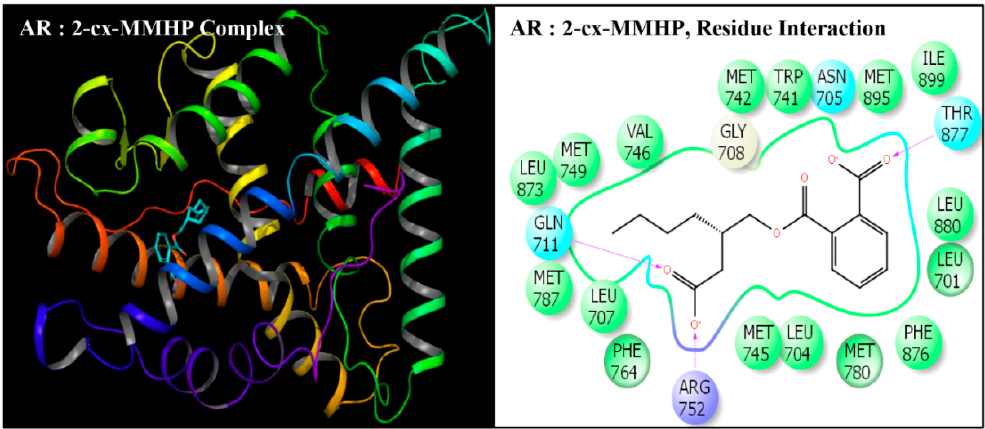
Figure 6. Ribbon diagram representing the docking pose of human androgen receptor (AR) with mono-(2-ethyl-5-carboxypentyl)phthalate (5-cx-MEPP) (left panel). The interactions of ligand (5-cx- MEPP) with amino-acid residues in the binding pocket of AR (right panel).